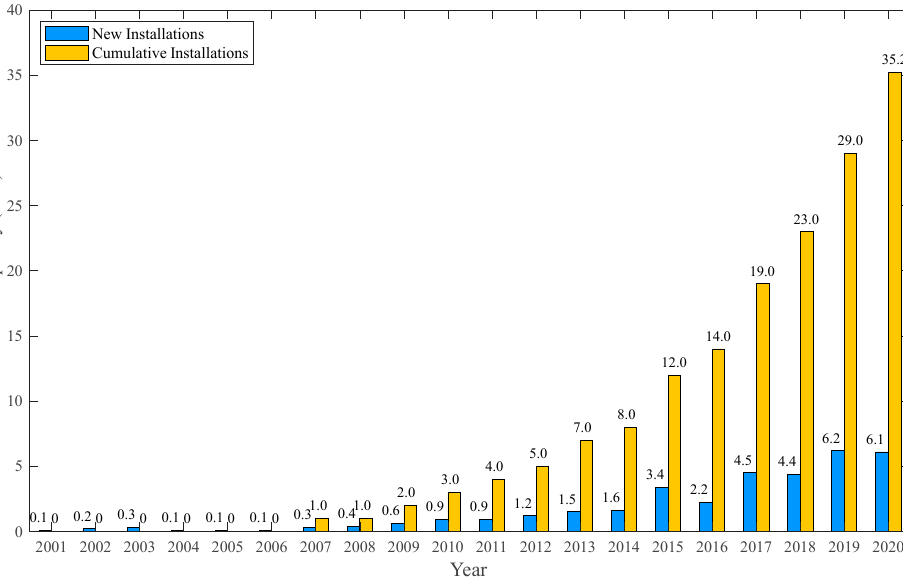
Figure 1. New and cumulative installed capacity of global offshore wind power from 2001 to 2020 [3].